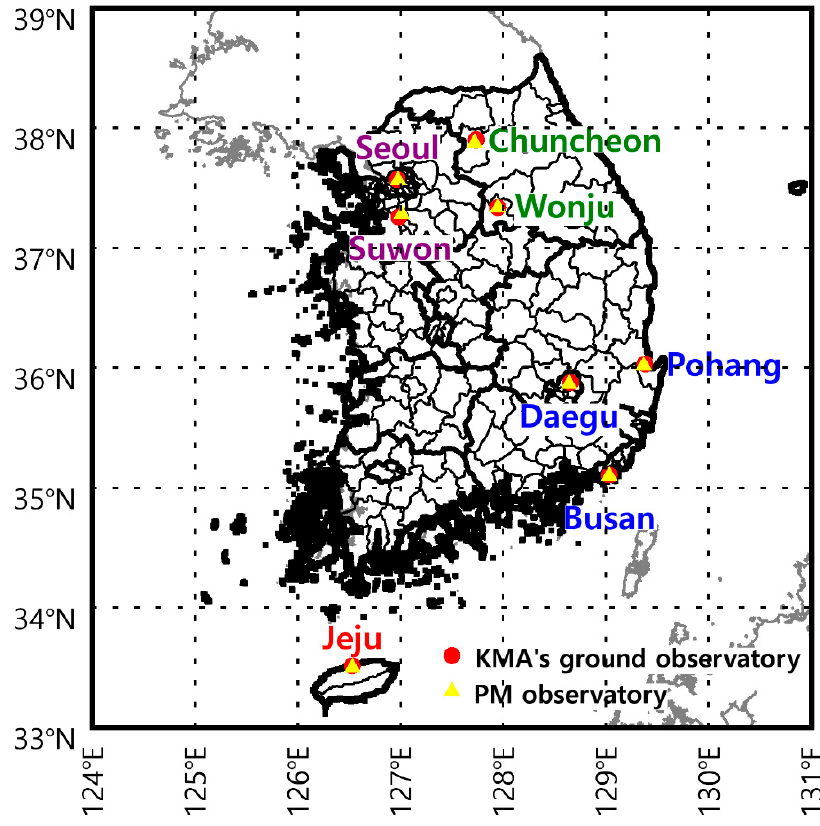
Figure 1. Location of cities studied.